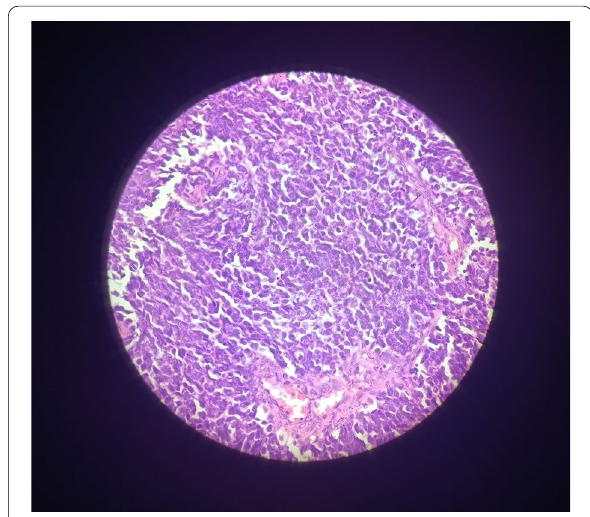
Fig. 3 Small-to-medium cells with eosinophilic cytoplasm, uniform and central nuclei, salts and pepper